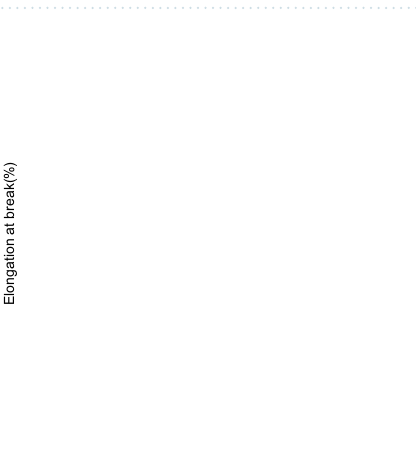
Figure 4. Effect of MCC content in casting solution on mechanical properties of the